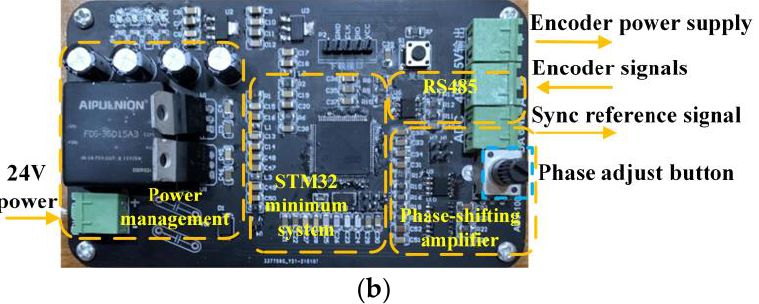
Figure 5. Sync reference signal acquisition circuit: ( a ) block diagram of circuit design; ( b ) PCB circuit diagram.